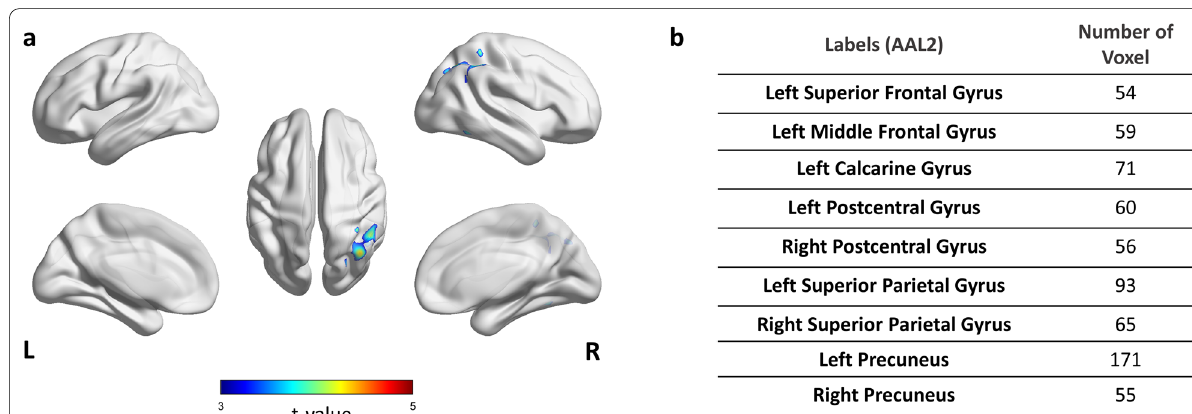
Fig. 6 Result of voxel-wise analysis and analyzing prediction values from submodules in the external validation dataset. a Areas of higher glucose metabolism in Aβ-negative PET scan participants compared to Aβ-positive PET scan participants. The results are presented with a threshold of p < 0.001, uncorrected, and 50 voxels. b Analysis result of prediction values from submodules. Abbreviation: AAL Aβ =